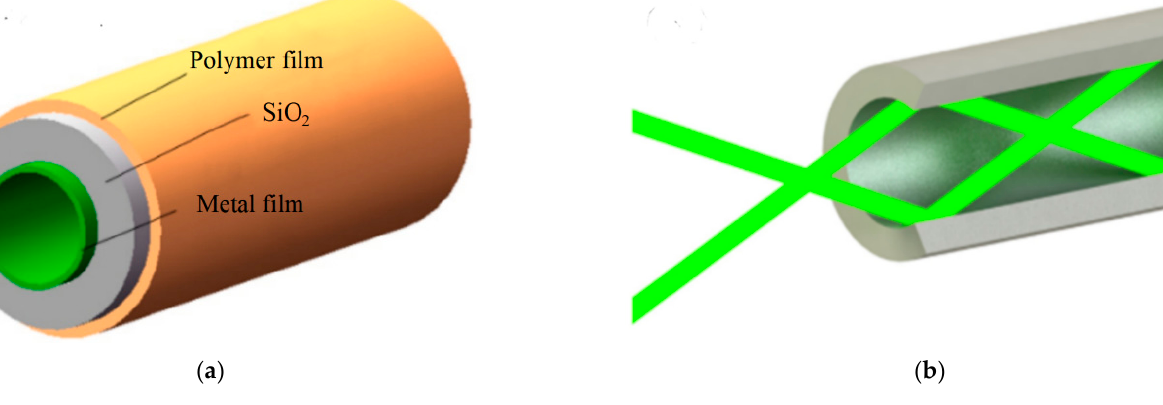
Figure 11. The structure and light guiding principle diagram of MLHCF. ( a ) Structure diagram. ( b ) Transmission mechanism of light in MLHCF. Reproduced with permission [10].